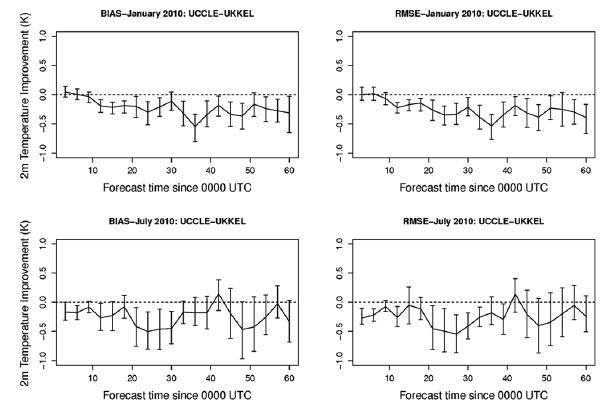
Fig. 3. The improvement in bias (left) and rmse (right) of the 2m temperature obtained when using SURFEX for Jan- uary (top) and July (bottom). The 95% confidence intervals for | bias |−| bias | and rmse − rmse OPER + SFX OPER OPER + SFX OPER were calculated with the bootstrap